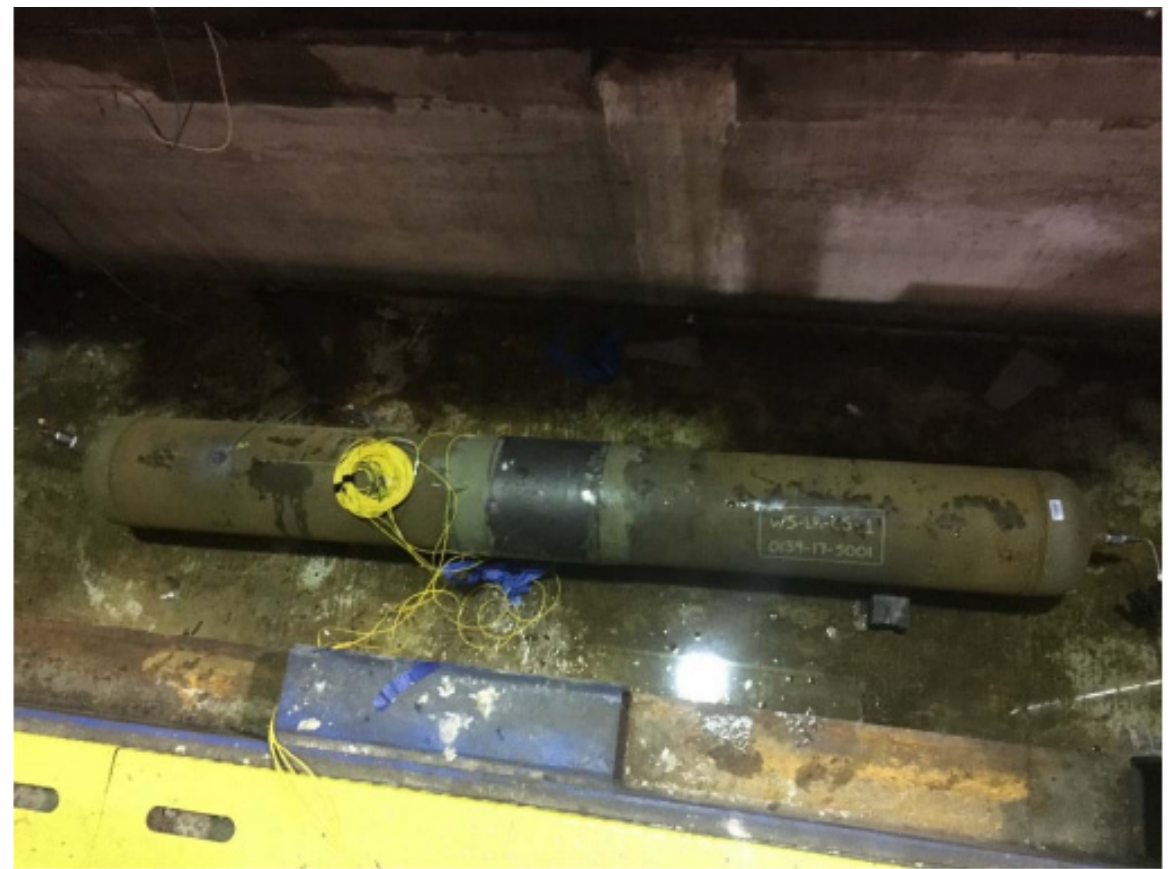
Figure 16 . Typical composite pipe repaired with ComposiSleeveTM sample (Reprinted/adapted with permission from Dr. Chris Alexander; Source: Ref. [63]. Copyright year: 2018, copyright owner’s name: ASME & Dr. Chris Alexander) .